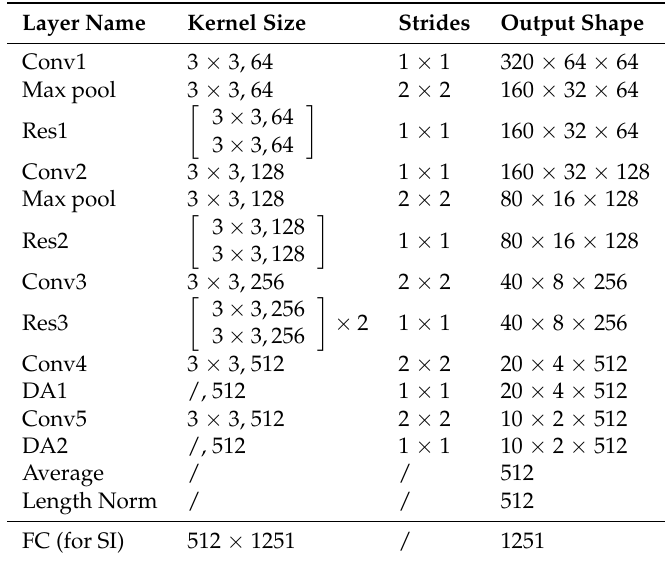
Table 5. The Residual (Res)-Dual-path Attention (DA) architecture. SI, Speaker